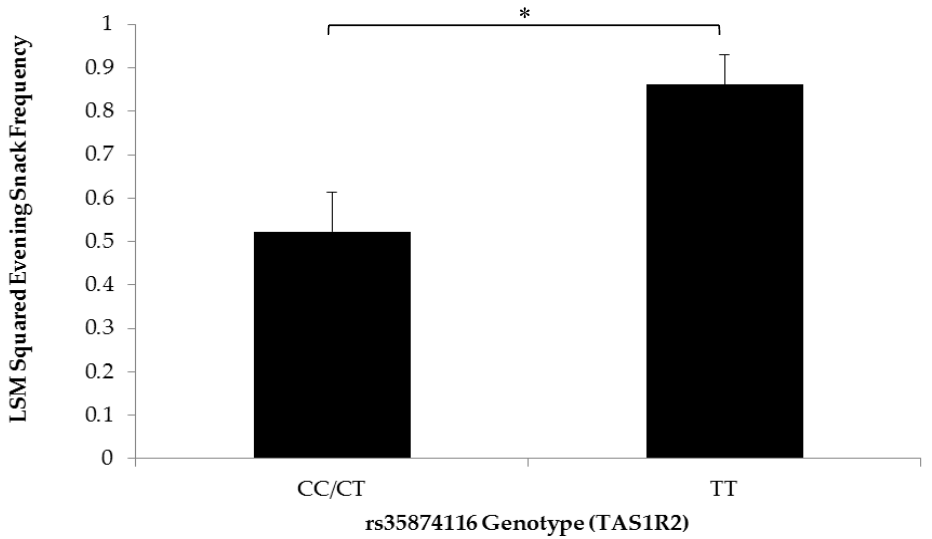
Figure 3. Least squares means of squared evening snack frequency by rs35874116 genotype Statistical differences between the square-transformed frequency of evening snacks for rs35874116 of the TAS1R2 sweet taste receptor gene were determined using generalized estimating equations ( n = 47; * p = 0.004) and a dominant genetic model [20]. Children carrying the TT genotype ( n = 25), predicted to prefer sweet more than carriers of the C allele ( n = 22), consumed more snacks in the evening. Values are reported as least squares means + SE.